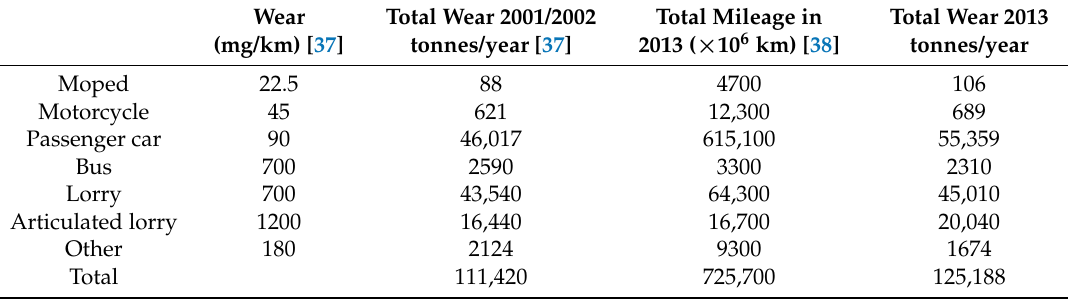
Table 6. Calculation of the amount of tyre wear and tear in Germany [37,38].